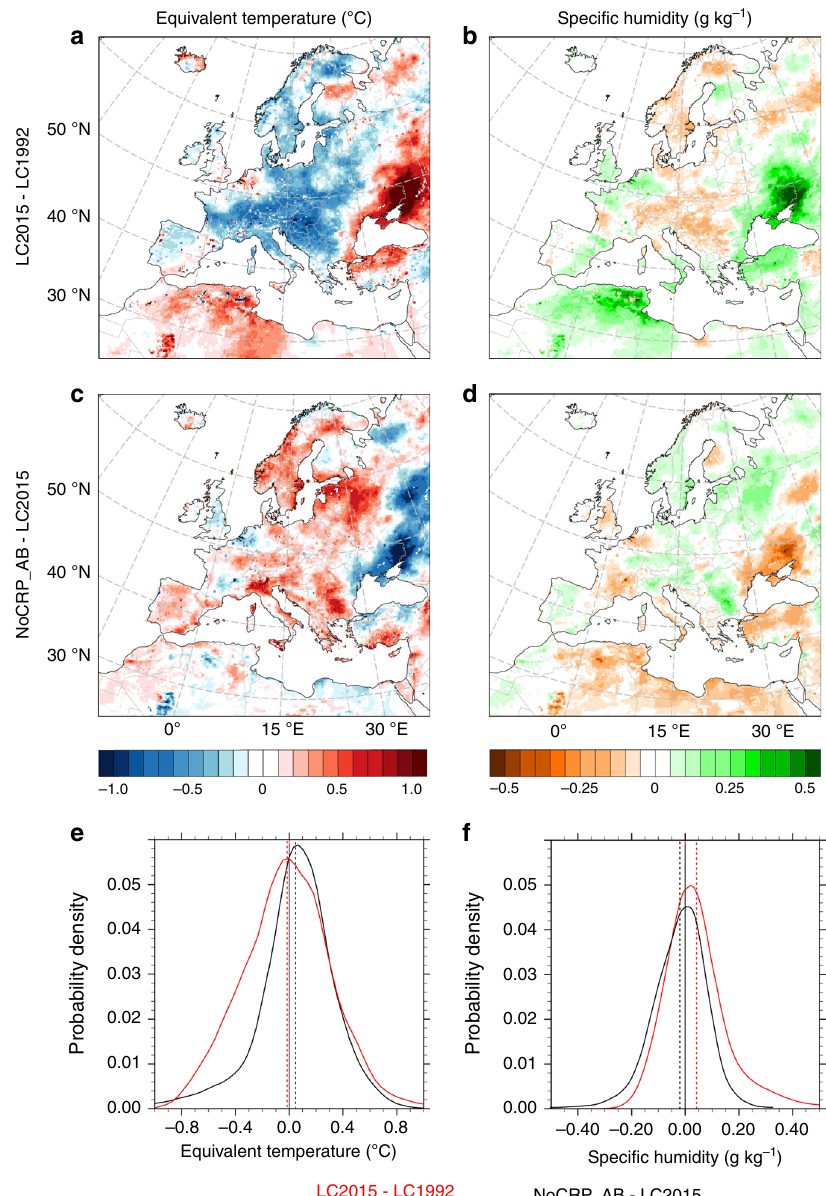
Fig. 3 Annual average changes in equivalent temperature ( T E ) and absolute speci fi c surface humidity ( q ) from recent (1992 – 2015) land cover transitions in Europe. Annual average T E changes (in ºC) due to the mix of land cover transitions ( a ) and from excluding contributions of cropland abandonment ( c ); probability distribution function of T E changes across the entire domain ( e ); annual average q changes (in g kg − 1 ) due to the mix of land cover transitions ( b ) and from excluding contributions of cropland abandonment ( d ); probability distribution function of q changes across the entire domain ( f ). In e and f , the solid line shows the distribution of the values and the dashed vertical line indicates the respective mean value. LC1992 and LC2015 refer to regional climate simulations with the European land cover in 1992 and 2015, respectively. NoCRP_AB refers to a land cover dataset where cropland in 1992 is not allowed to convert to other land